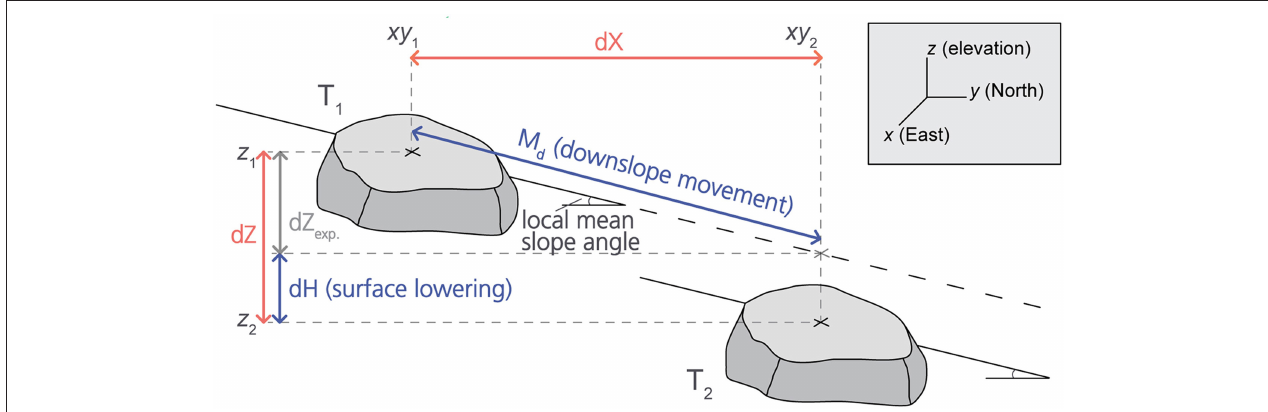
FIGURE 4 | Sketch showing the principle of a dGPS measurement and the parameters that can be calculated with a moving block: dX ( horizontal movement ), dZ ( vertical movement ) and, if the slope angle has not significantly varied during the two measurements, M d ( downslope movement , derived from dX and the local mean slope angle), dZ exp . ( expected vertical movement derived from dX and the local mean slope angle) and dH (the difference between expected movement and the measured vertical movement; this parameter is an expression of surface lowering).